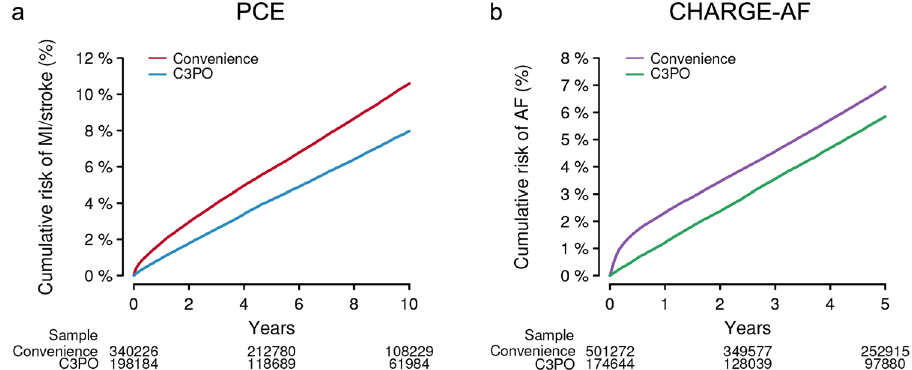
Fig. 5 Cumulative event risk in C3PO versus Convenience Samples. Depicted is Kaplan – Meier cumulative risk of MI/stroke ( a ) and AF ( b ) observed in C3PO (blue [left] and green [right]) versus the Convenience Samples (red [left] and purple [right]). The number of individuals remaining at risk over time is labeled below each plot. Note an initial rapid in fl ection in MI/stroke and AF incidence observed in the Convenience Samples but not in